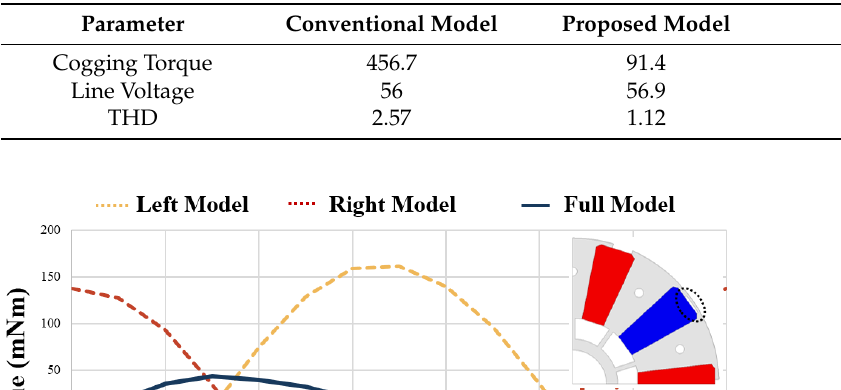
Figure 11. Cogging torque according to the asymmetric shape of the rotor barrier. Table 2. Comparison of no − load performance of the conventional spoke − type model and the pro- posed model.